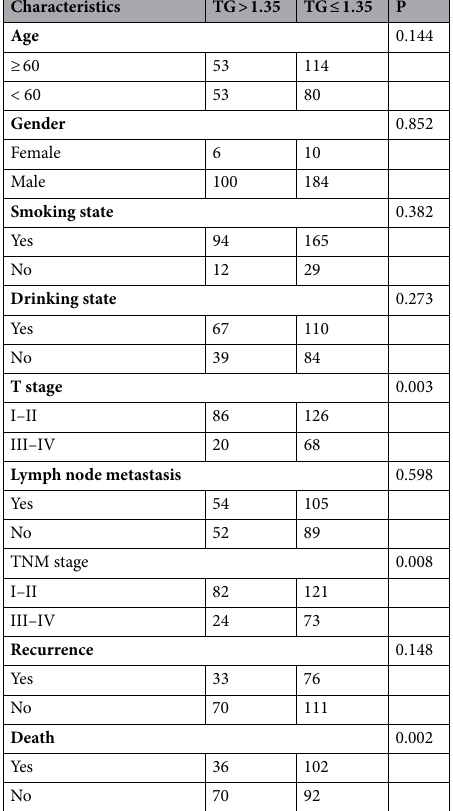
Table 3. Relationship between TG concentration and clinical characteristics in 300 patients with squamous cell carcinoma of lung based on chi-square